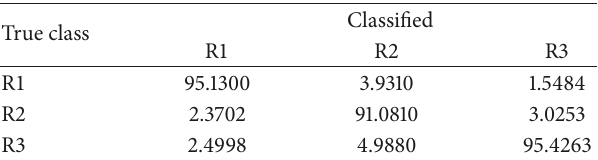
Table 2: Classification confusion matrix for fixed payload data: hand-shaking signal of radios (%).